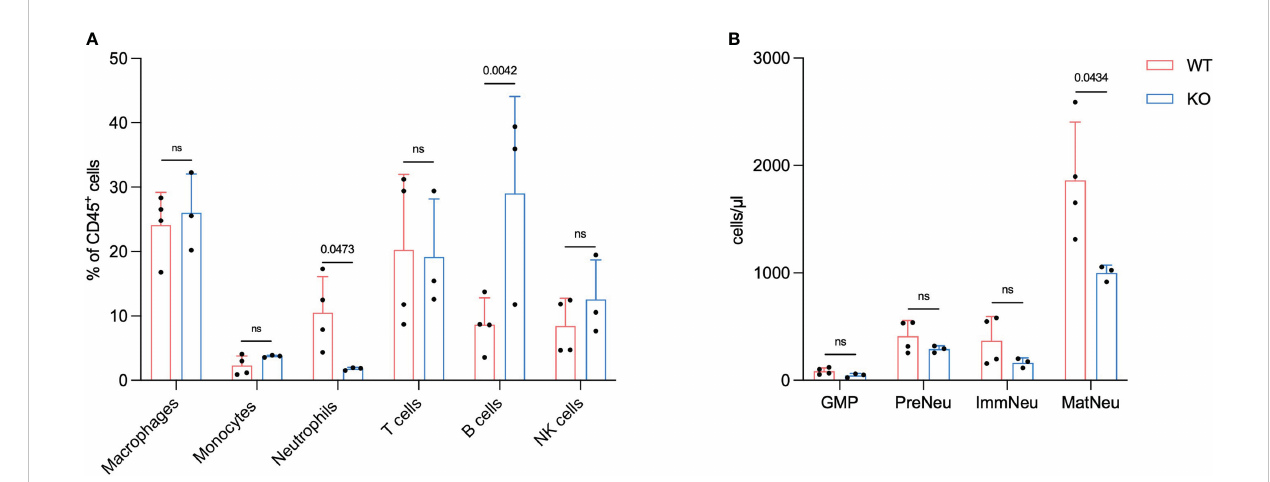
FIGURE 3 FES null mice have a reduced number of neutrophils in metastatic liver and bone marrow. Flow cytometry analysis 21 days post intrasplenic injection from mice with hepatic PDAC metastases (A) , Macrophages, monocytes, neutrophils, t cells, B cells and NK cells (sample from metastatic livers) (WT mice n=4, FES null mice n=3). (B) , GMPs, pre-neutrophils (PreNeu), immature (ImmNeu) and mature neutrophils (MatNeu) (sample from BM). Bar graphs represent mean and standard deviation; hypothesis testing was performed using unpaired two-sided Student ’ s t